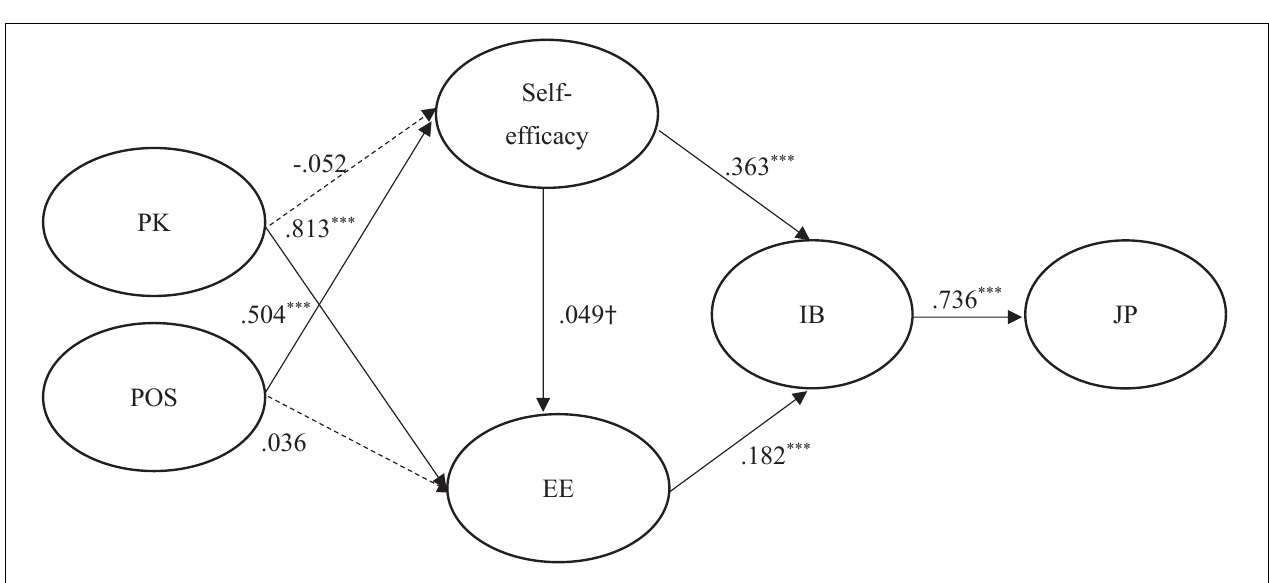
FIGURE 3 | Structural model on mainland China employees. PK, prior knowledge; POS, perceived organizational support; EE, employee employability; IB, innovation behavior; JP, job performance. *** p < 0.001 and † p < 0.1.